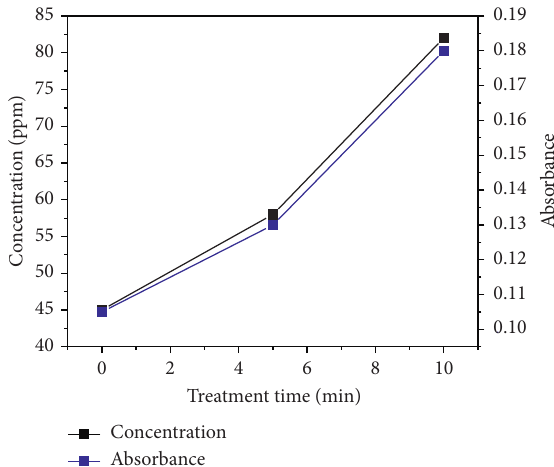
Figure 12: Absorbance and concentration of nitrite ions with treatment time (5kV, 19.56kHz, and 5L/min).